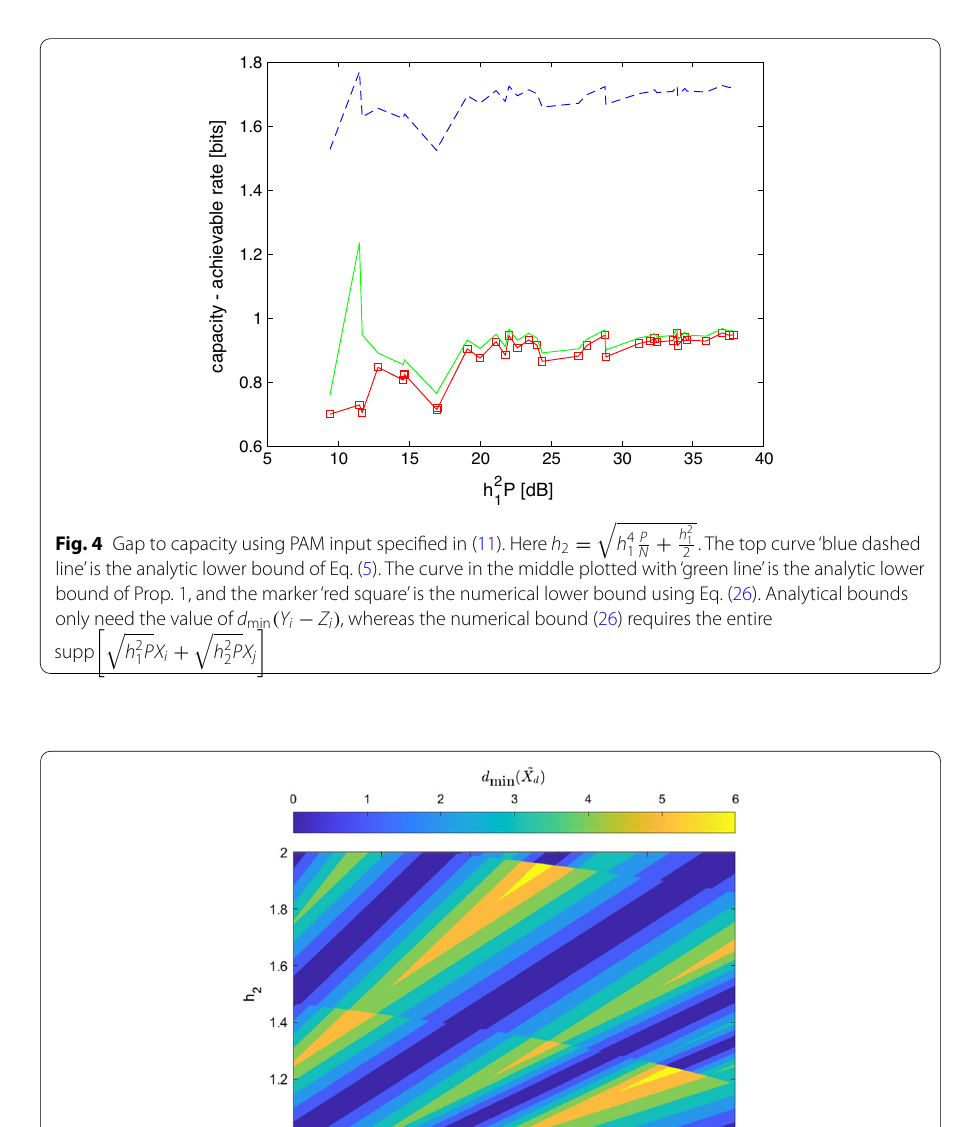
Fig. 5 Minimum distance. Minimum distance at the receiver Y 1 for the discrete constellation channel coefficients vary. Here P / N